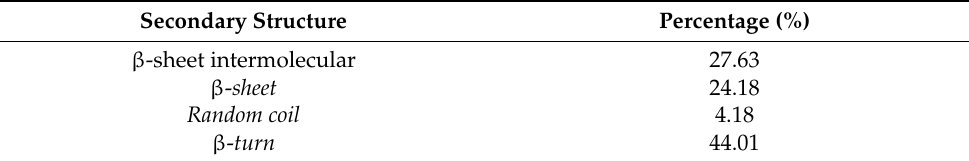
Table 2. Secondary structure of